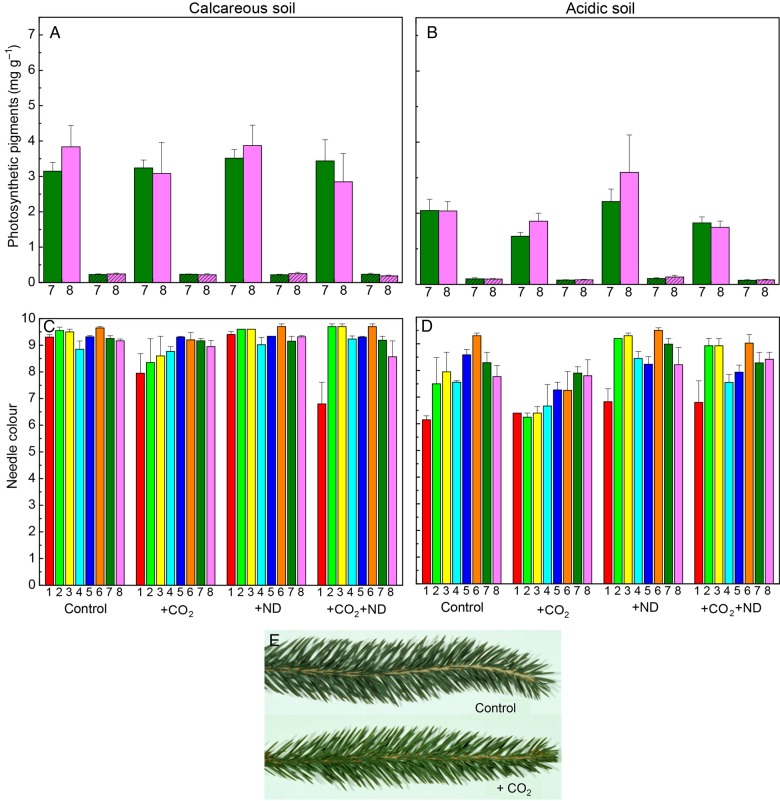
The change in the concentration of photosynthetic pigments in July (A and B), namely chlorophyll a + b and α + β carotenoids (hatched columns), and in the needle colour in September (C and D) in the current-year foliage of several European spruce origins (bar colours = Fig. 5) growing on either acidic or calcareous forest soil in response to +CO2, +ND and +CO2 + ND versus control (mean values + SE, N = 4). (E) Typical examples of needle discolouration in response to elevated CO2.